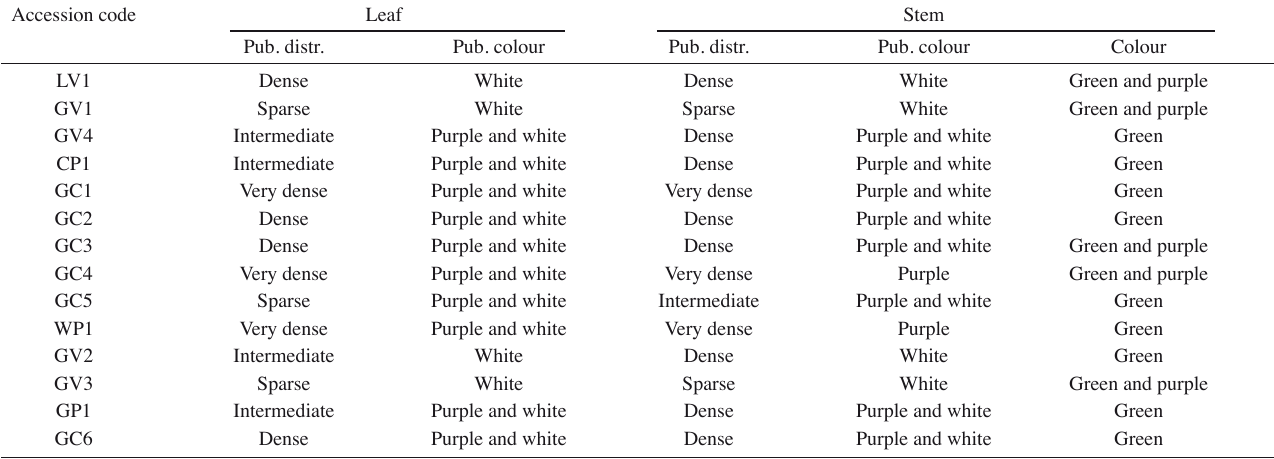
Tab. 1: Morphological characterisation of leaves and stems of fourteen Solanum anguivi Lam. accessions. Accession code